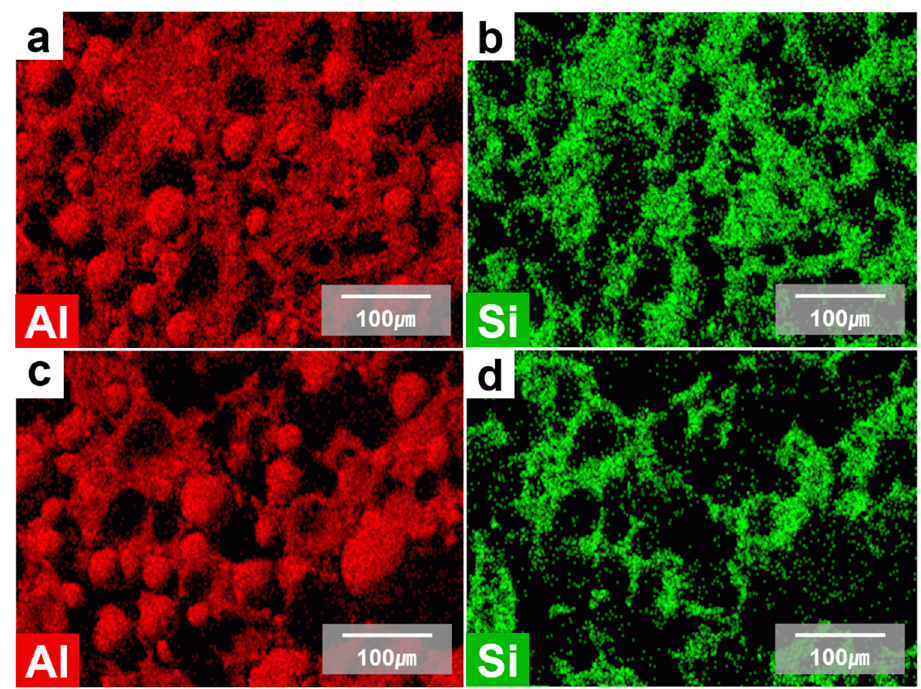
Figure 3. EDS mapping of thermal pads using aluminum oxide powder of ( a , b ) type B and ( c , d ) type E. Al and Si are represented by red and green colors, respectively.